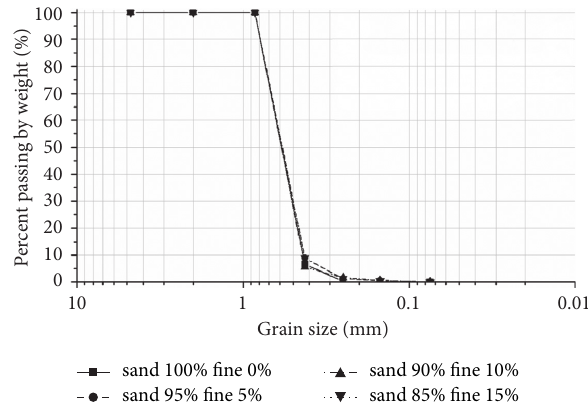
Figure 3: Particle size distribution of the tested